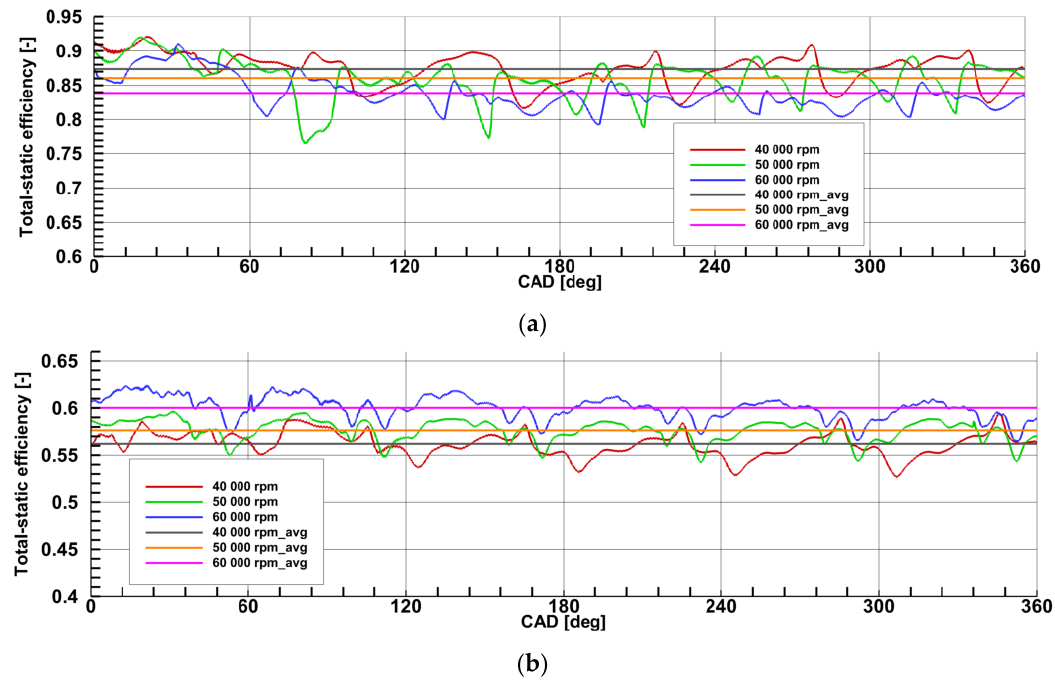
Figure 17. The total-static efficiency for three different turbine speeds, during the 3rd revolution of the crankshaft of the: ( a ) first-stage rotor; ( b ) second-stage rotor.